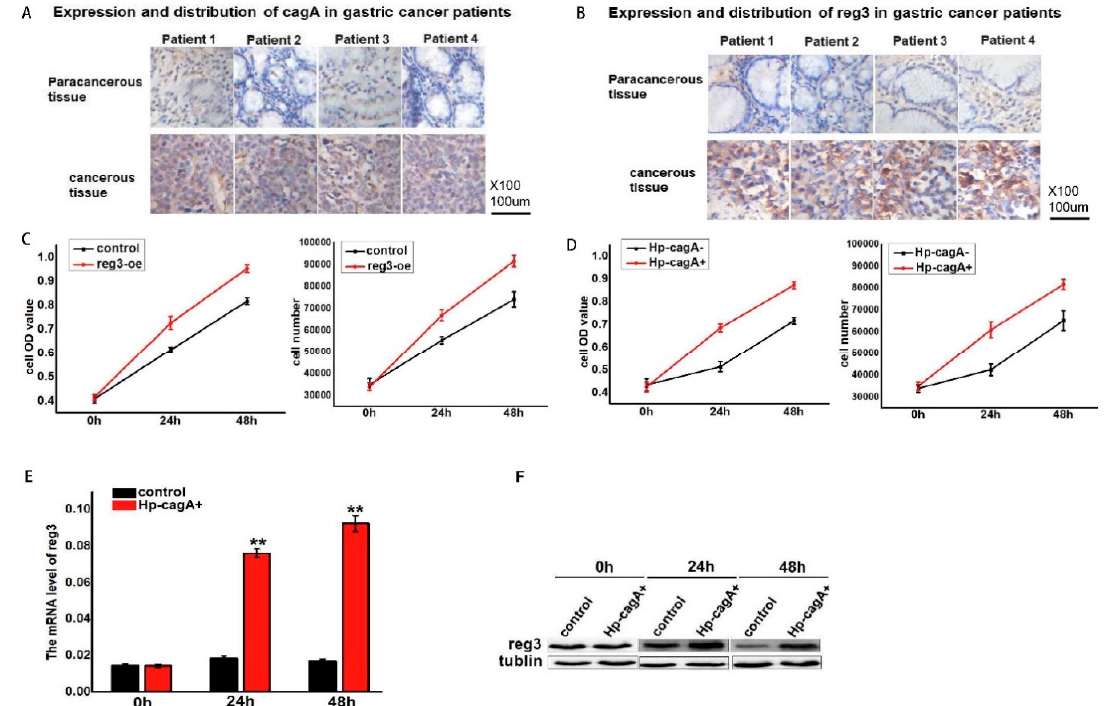
Figure 2. CagA promotes cell proliferation by regulating reg3 . ( A ). Immunohistochemistry was used to detect the expression of CagA in gastric cancer. ( B ). Immunohistochemistry was used to detect the expression of reg3 in gastric cancer. ( C ). The effect of reg3 on cell proliferation was detected by the MTT assay and cell counting. ( D ). The effect of CagA on cell proliferation was detected by the MTT assay and cell counting. ( E ). The mRNA level of reg3 expression was detected at 0, 24, and 48 h after HP-CagA + was transfected into gastric cancer cells. ** p value ≤ 0.01. ( F ). The protein level of reg3 expression was detected at 0, 24, and 48 h after HP-CagA + was transfected into gastric cancer cells.